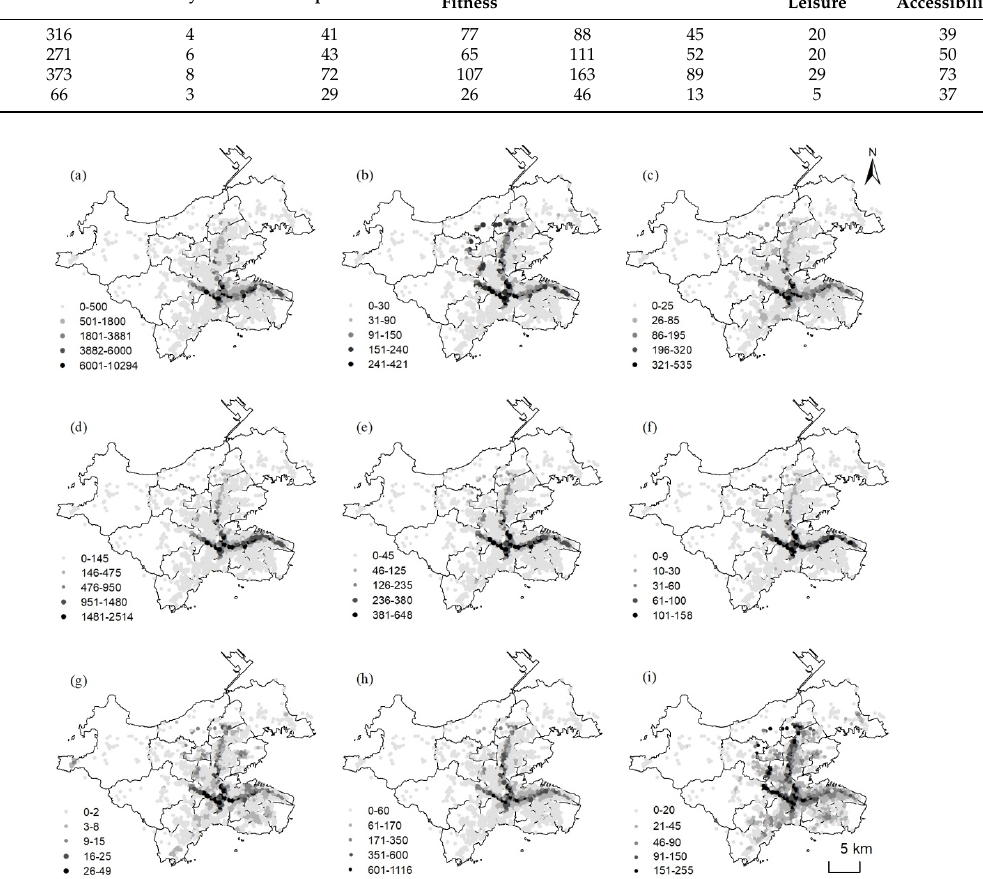
Figure 4. Public service facility accessibility within the central urban area of Dalian. ( a ) Represents shopping/catering; ( b ) represents transportation facilities; ( c ) represents educational facility; ( d ) represents life services; ( e ) represents physical fitness; ( f ) represents cultural/leisure facilities; ( g ) represents elderly care facilities; ( h ) represents medical facilities; ( i ) represents total facilities. Regionally, the comprehensive accessibility of various PSFs in the Shahekou District was the highest, as it is a compound functional area. Next, the accessibility of shopping, catering, living services, sports and fitness, as well as that of cultural and leisure facilities in the Zhongshan District was higher than that in the other two districts, while the acces- sibility of elderly care, transportation, medical, as well as educational facilities in the Xigang District was greater than that in the other two districts. Overall, the accessibility of various service facilities in the Ganjingzi District was the poorest, indicating inequal accessibility.